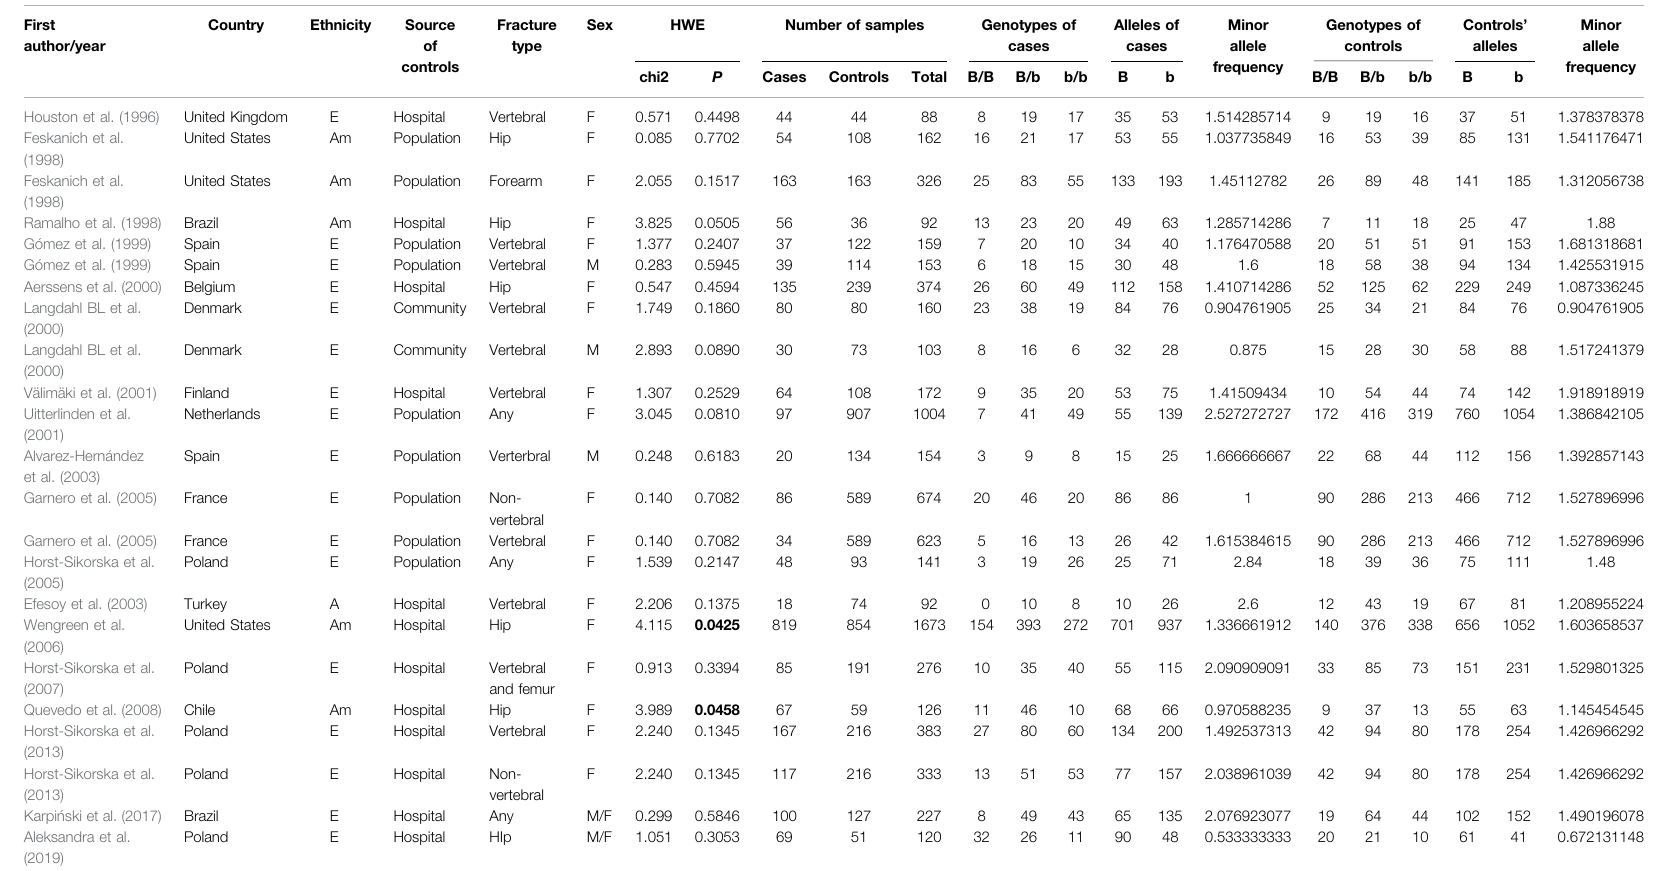
TABLE 2 | Genotype frequencies of VDR BsmI polymorphism in studies included in this